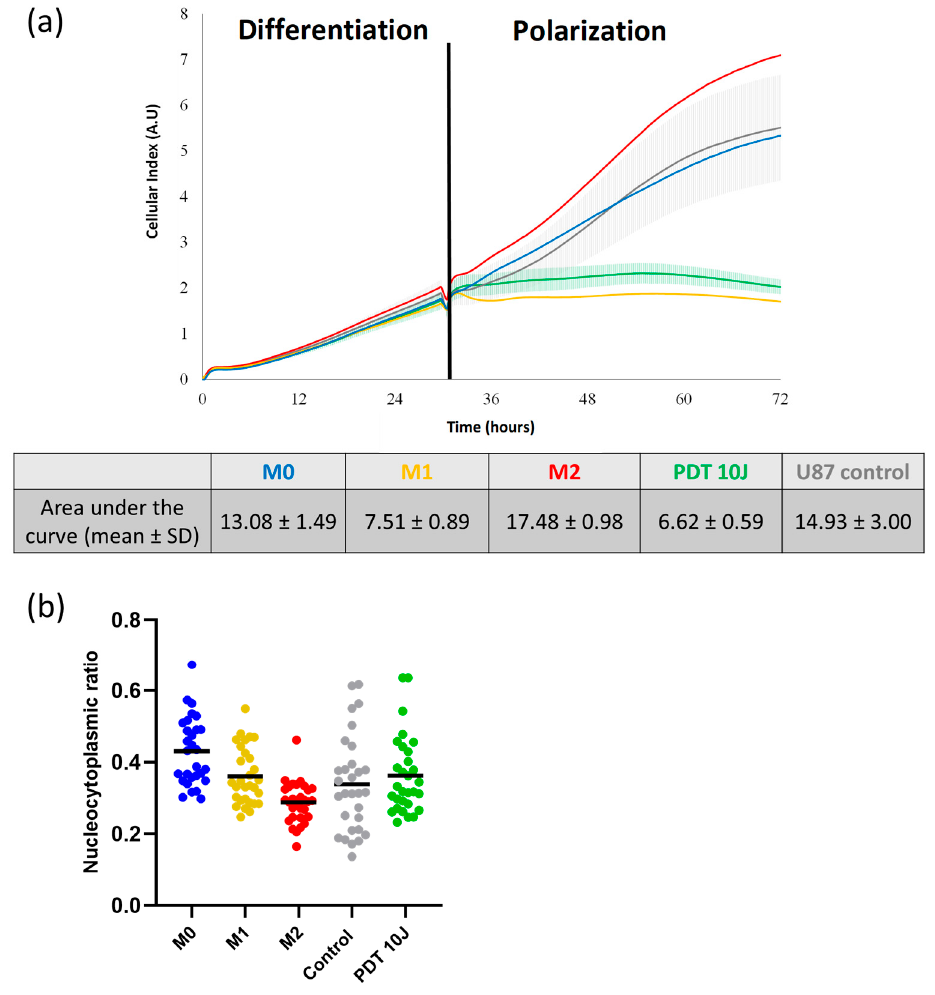
Figure 7. Influence of U87 secretome pre- and post-PDT on macrophage polarization. Impedance measurements were performed for 72 h, including the differentiation (24 h) and polarization (48 h) phases. ( a ) After the differentiation step, macrophages were contacted with secretome from U87 cells or from U87 post-PDT using AGuIX@PS@KDKPPR (1 µ M) at a fluence of 10 J · cm − 2 . The mean is shown as a solid line with the variability of the replicate measurements (4 replicates/group). Area under the curve was calculated between 24 h and 72 h during the polarization phase. (AU arbitrary unit). ( b ) Macrophages nucleocytoplasmic ratio values for M0, M1, and M2 macrophages compared to macrophages in contact with secretome of U87 cells pre-PDT (Control) and post-PDT (PDT 10J) (30 cells/condition). Each point represents one cell ( n = 30).